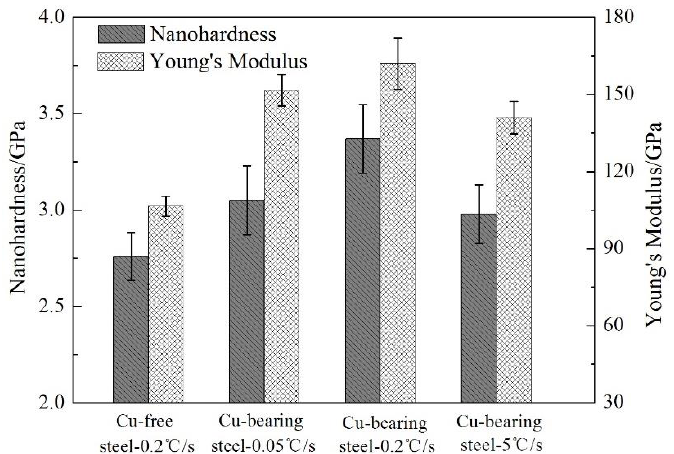
Figure 7. The micro-mechanical properties of Cu-free and Cu-bearing steels.